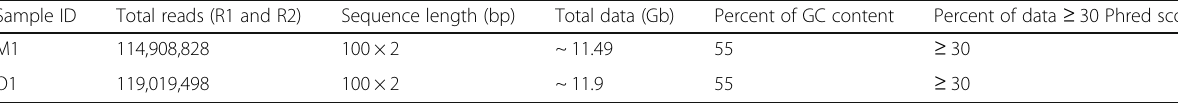
Table 1 Description of the raw reads, percent of GC content, and quality score